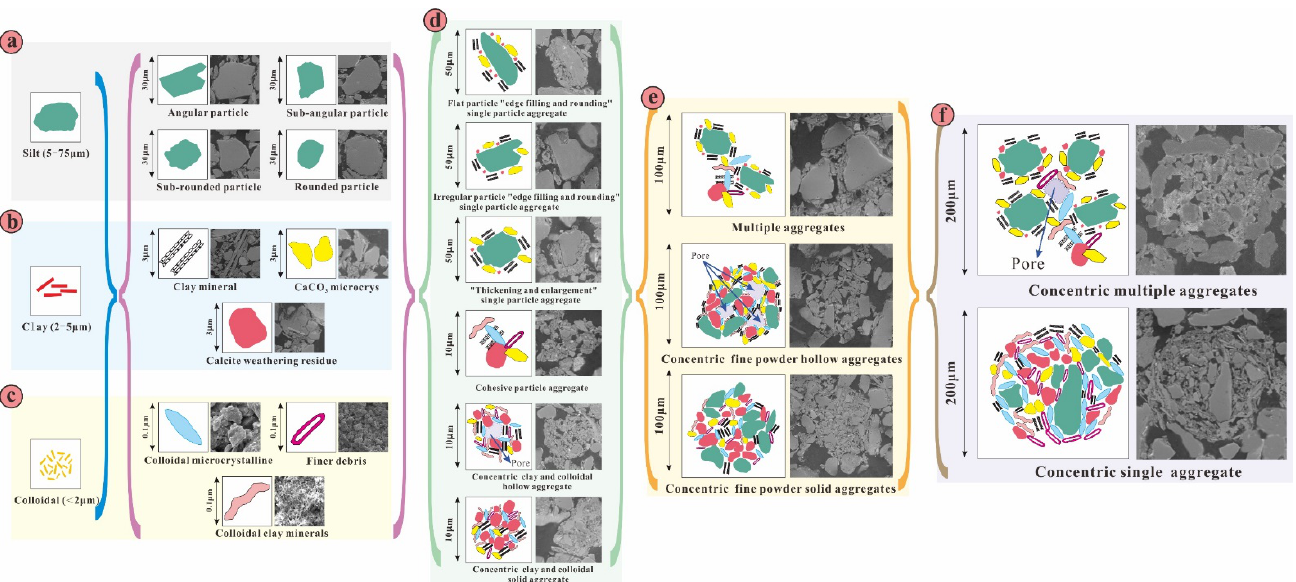
Figure 3. Conceptual model of aggregation hierarchy: ( a ) Silt in loess; ( b ) Clay in loess; ( c ) Colloidal in loess; ( d ) The first level of aggregate. Silt, clay and colloidal particles form smaller aggregates under physical action, which are mainly small single aggregates. There are two types, one is the aggregate formed by clay and colloidal particles wrapped around silt or sand, and the other is the matrix aggregate formed by clay and colloidal only; ( e ) The second level aggregate is composed of two smaller aggregates from the previous level to form a larger one; ( f ) The aggregates with higher aggregation level are almost spherical or ellipsoidal in three dimensional space.